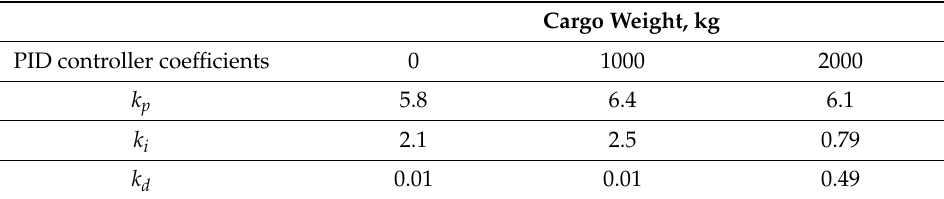
Figure 12. Schematic window of the VI-IM submodel with additional load mass input. The calculated PID regulator coefficients for different cargo weight of the transport robot are shown in Table 2. Table 2. Calculated PID regulator coefficients for different cargo weight.